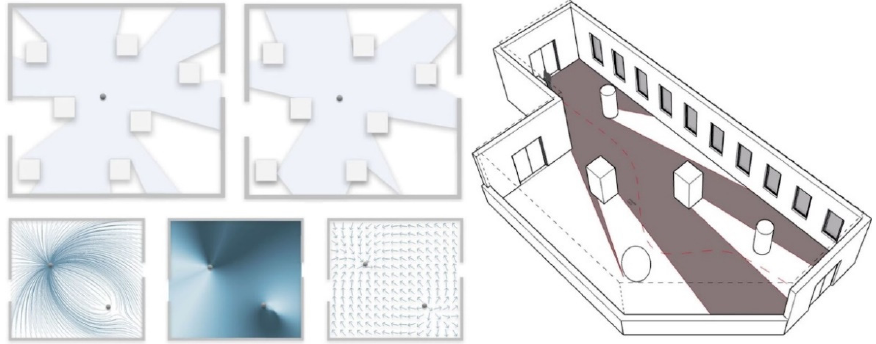
Figure 6. Top left: graphic representation of the isovist, a variable used to calculate the amount of space visible from any point within an environment. Below: diagrams representing the intensity of the charge generated by a point entity, in relation to the characteristics of the associated metadata. Right: spatial visualization of the isovist and the path of a visitor based on the attractive power associated with the collections.